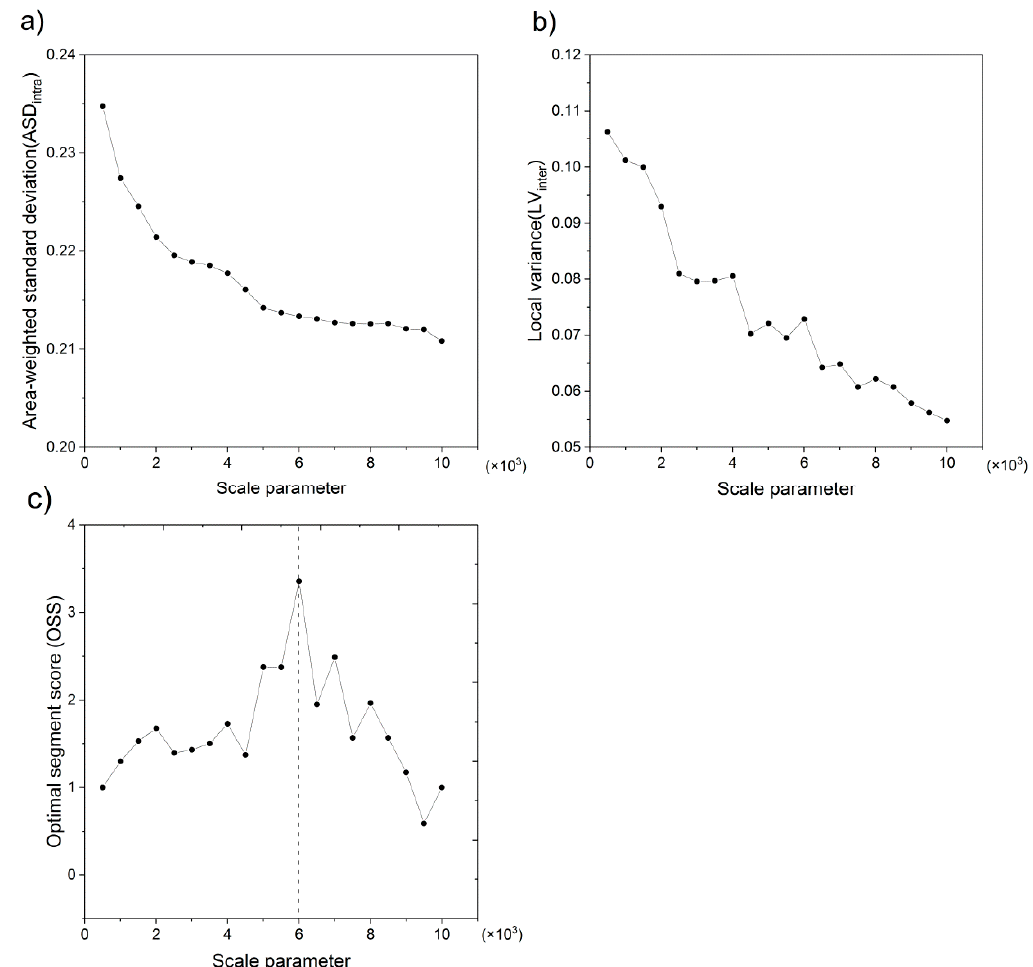
Figure 6. Parameter determination for ( a ) area-weighted standard deviation of each stratification (ASD intra ); ( b ) mean standard deviation of the stratifications (LV inter ); ( c ) optimal segment score (OSS) as a function of scale parameter. Setting in eCognition software: Shape = 0.1, compactness = 0.5.